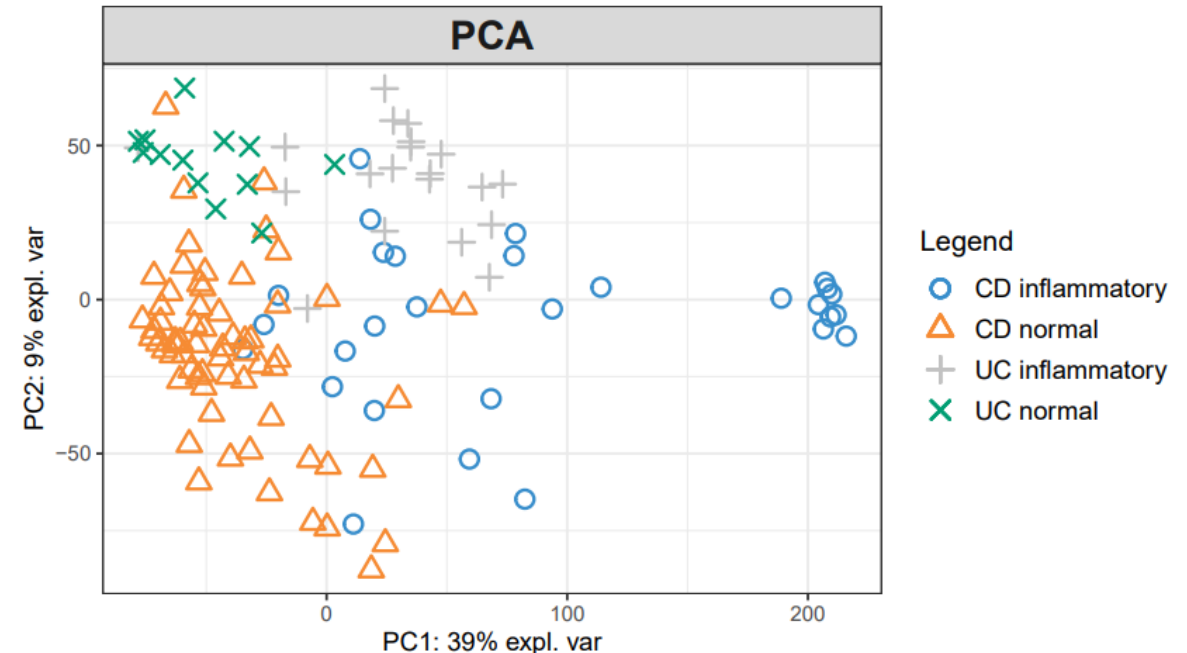
Figure 1. Principal component analysis plot of IBD samples. Normalized log-transformed expression values from edgeR were used in the PCA up to 10 components. The first two components that explained 48% of the total variance are shown in the plot drawn with the Bioconductor R package mixOmics .